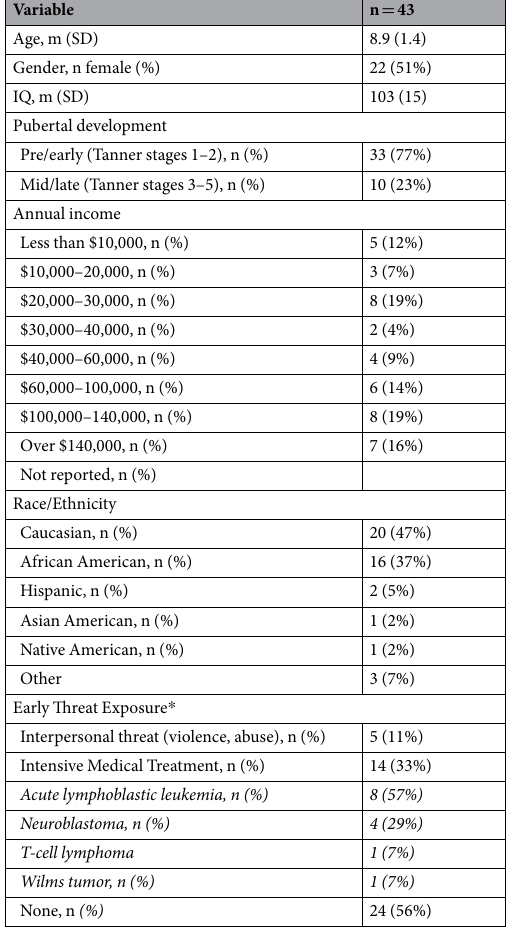
Table 1. Sample characteristics and demographics. Abbreviations: n, number; m, mean; SD, Standard deviation. * Interpersonal threat exposure was assessed using the Juvenile Victimization